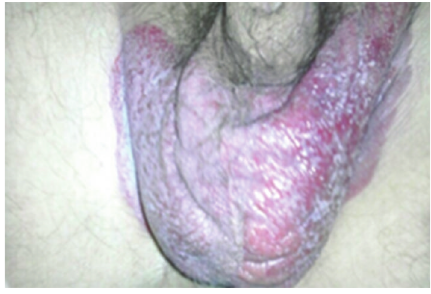
Figure 4: EMPD involving the scrotum and left thigh after two rounds of imiquimod 5% topical